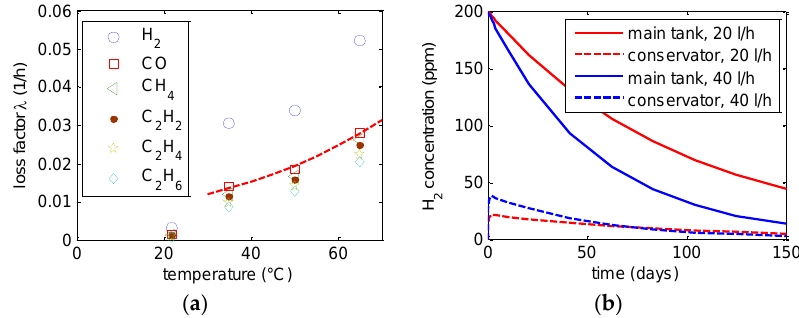
Figure 17. ( a ) Gas loss factors of different fault gases over temperature. Dashed line: exemplary exponential gradient for CO; and ( b ) concentration trend for H 2 in main tank (straight line) and conservator (dashed line) at different oil exchange rates.